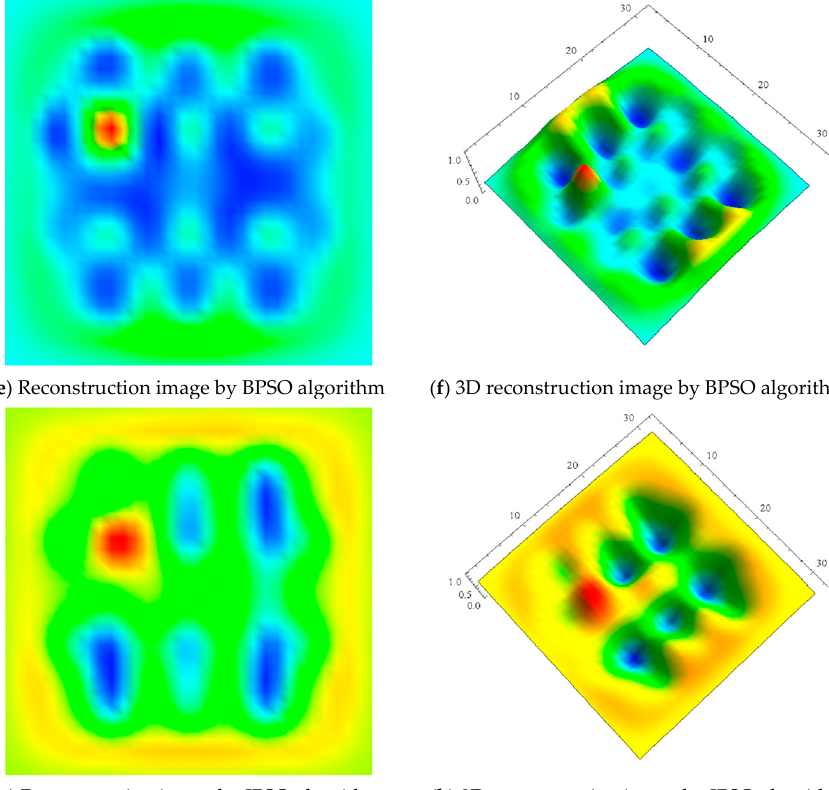
Figure 7. Images reconstructed by different algorithms for Sample 2.